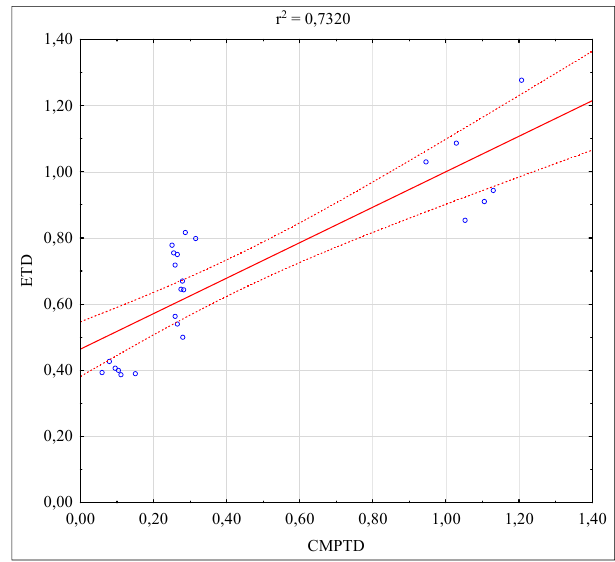
Figure 10. The level of linear association between the CMPTD and ETD .